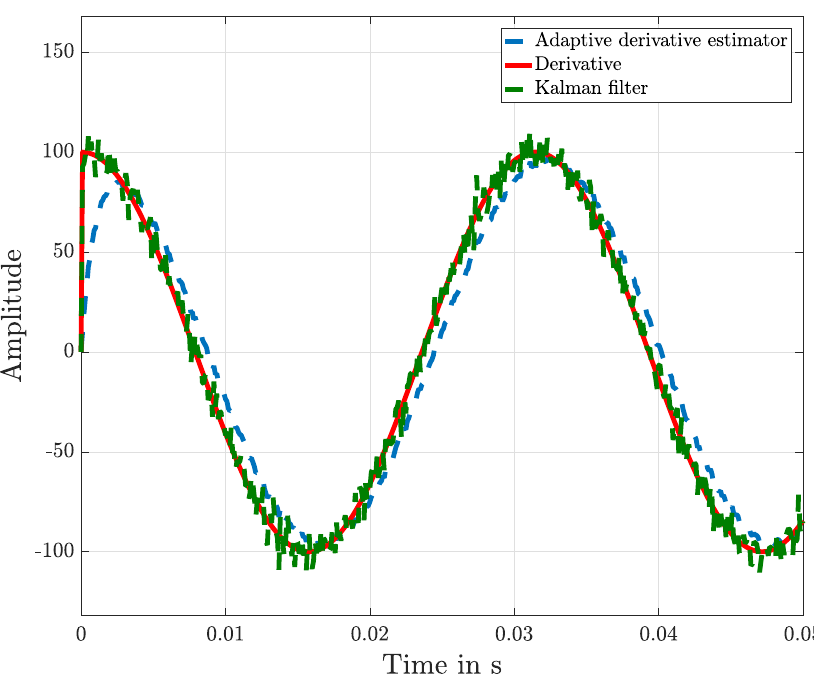
Figure 6. Detailed representation of Figure 5 and its estimations.